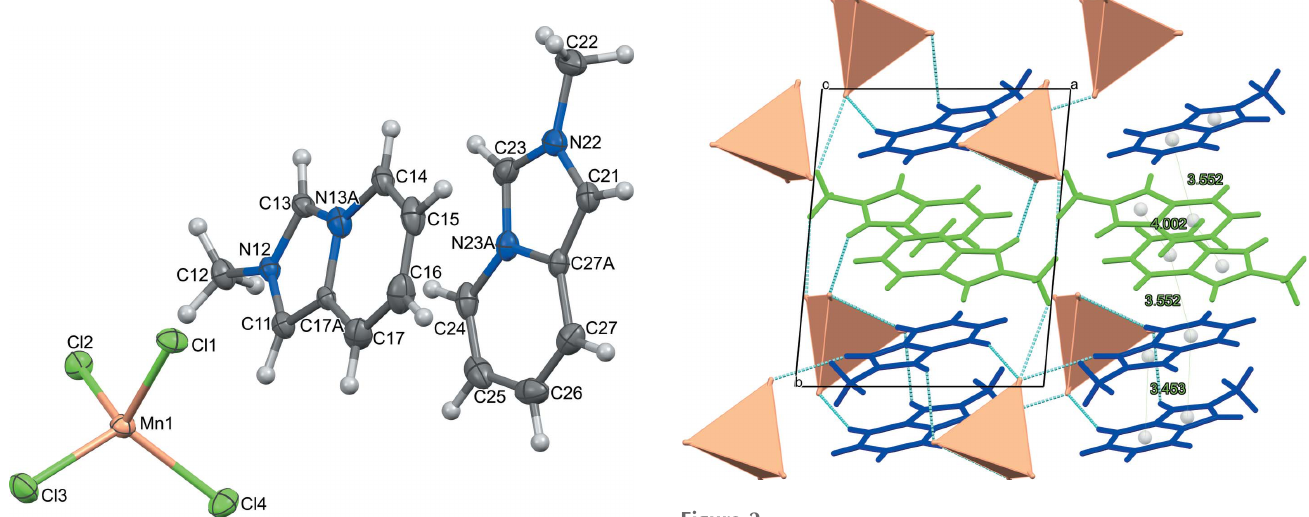
Figure 2 Fragment of the crystal packing of I viewed along the c axis with the non- equivalent L 1 + and L 2 + cations shown in blue and green, [MnCl 4 ] 2– anions are presented in a polyhedral form, and C—H (cid:3)(cid:3)(cid:3) Cl—Mn hydrogen bonds are shown in blue.